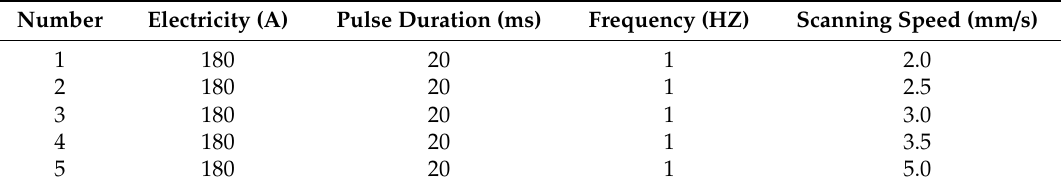
Table 2. Processing parameters of the biomimetic samples.